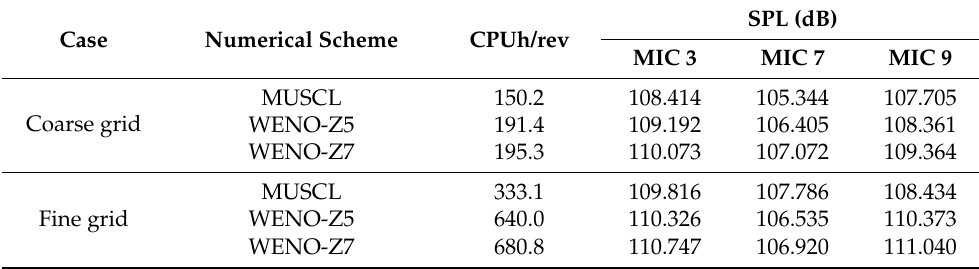
Table 2. Comparisons of the computational costs and SPLs of the WENO-Z and the MUSCL schemes for coarse and fine